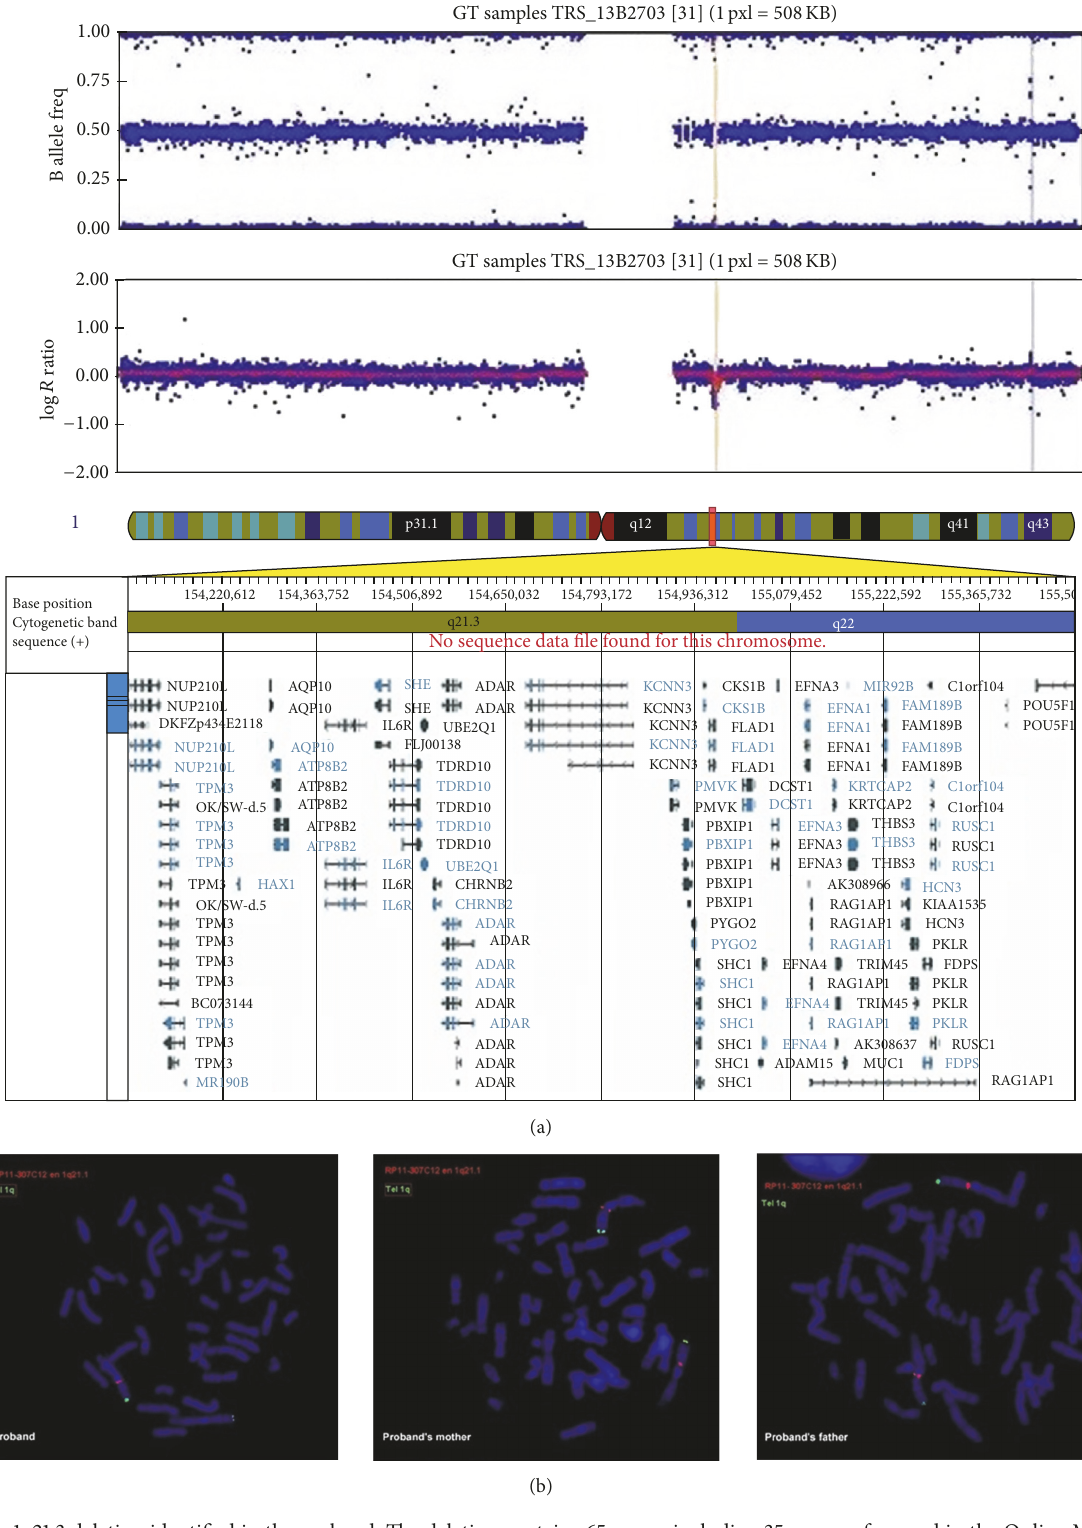
Figure 1: 1q21.3 deletion identified in the proband. The deletion contains 65 genes, including 35 genes referenced in the Online Mendelian Inheritance in Man (lower panel) (a). Fluorescence in situ hybridization (probe RP11-307C12, red spots) confirmed that the deletion was present in the proband but not in his parents